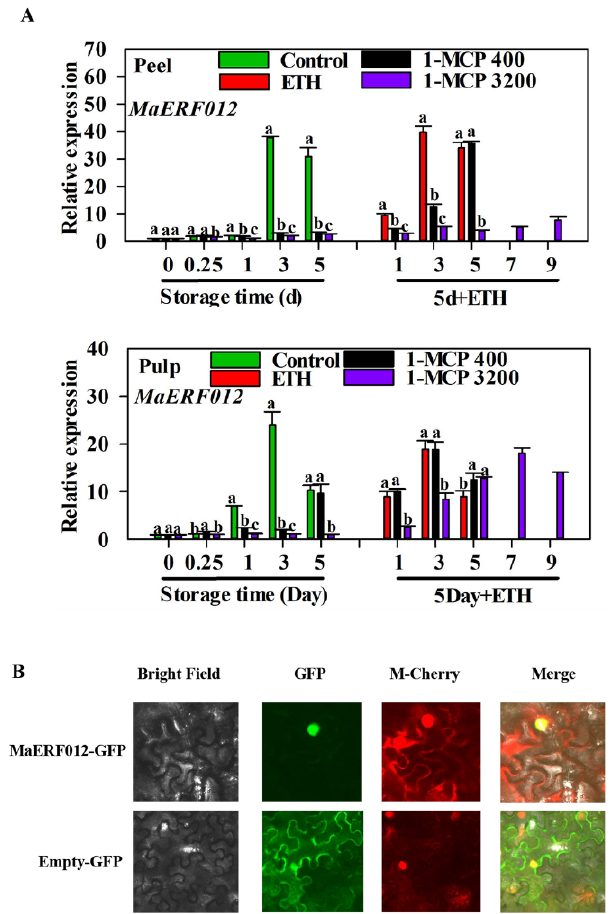
Figure 2. The expression profile and subcellular localization of MaERF012 . ( A ) The expression of MaERF012 in fruit peel and pulp under different treatments during storage. Different letters indicate significant difference ( p < 0.05). ( B ) Subcellular localization of MaERF012 . MaERF012-GFP and the positive controls pEAQ-GFP and M-Cherry were transiently expressed in tobacco leaves. The images were obtained using a fluorescence microscope with green fluorescence. Bars = 50 µm.